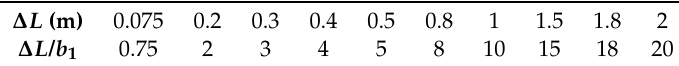
Table 3. Different intervals ∆ L and relative intervals ∆ L / b 1 .